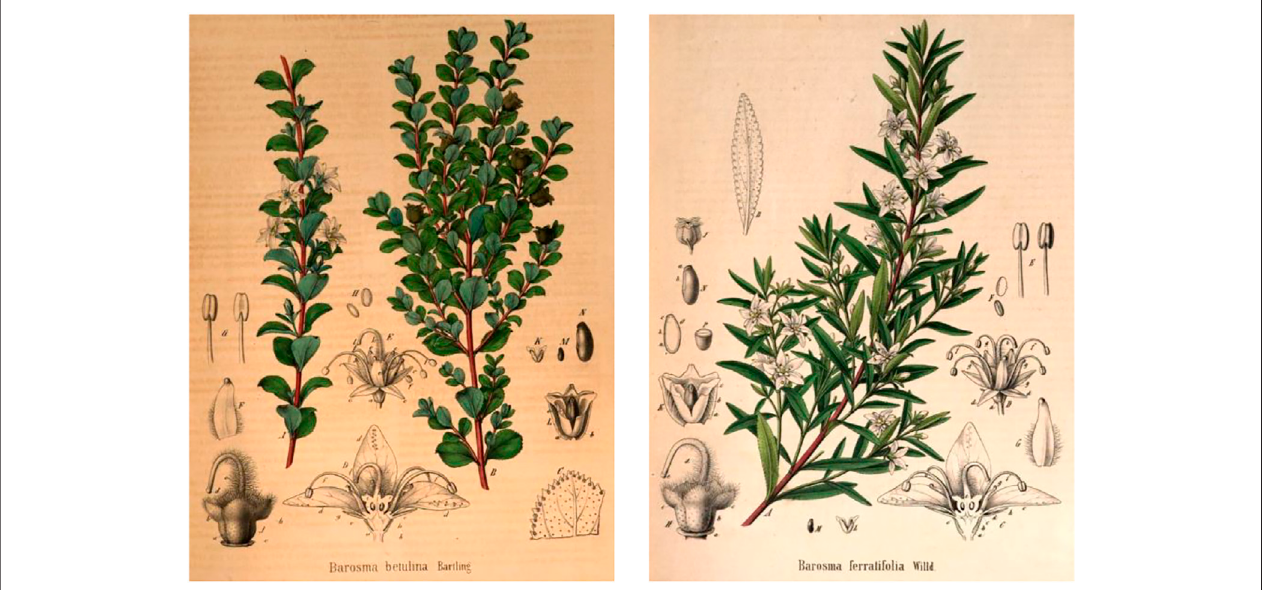
FIGURE 6 | Agathosma spp. compendial in the Pharmacopoeia Borussica (1846ff) (Berg and Schmidt, 1858).